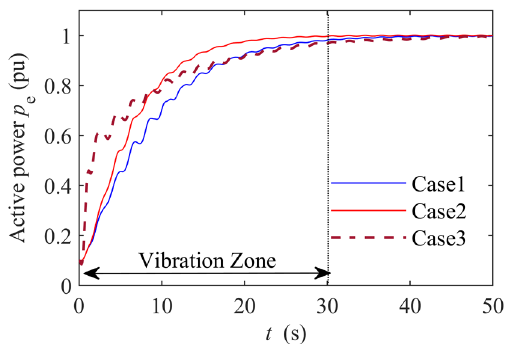
Figure 8. Response curves of p e with different controls.